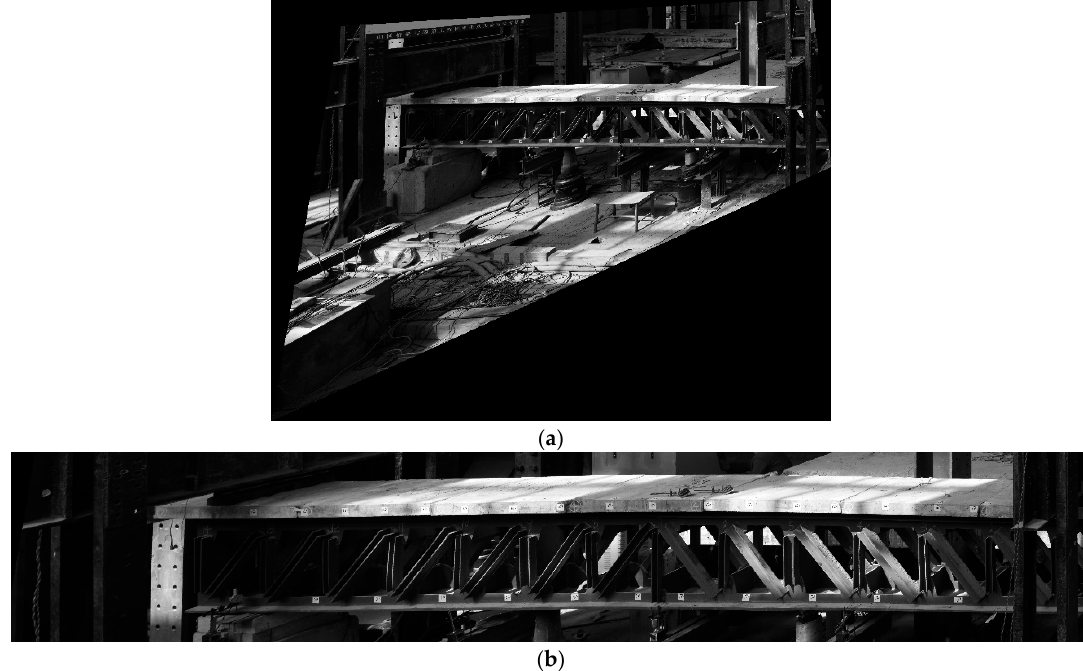
Figure 8. Perspective transformation of the tested beam; ( a ) after perspective transform; ( b ) integral drawing of specimen after projection transformation.